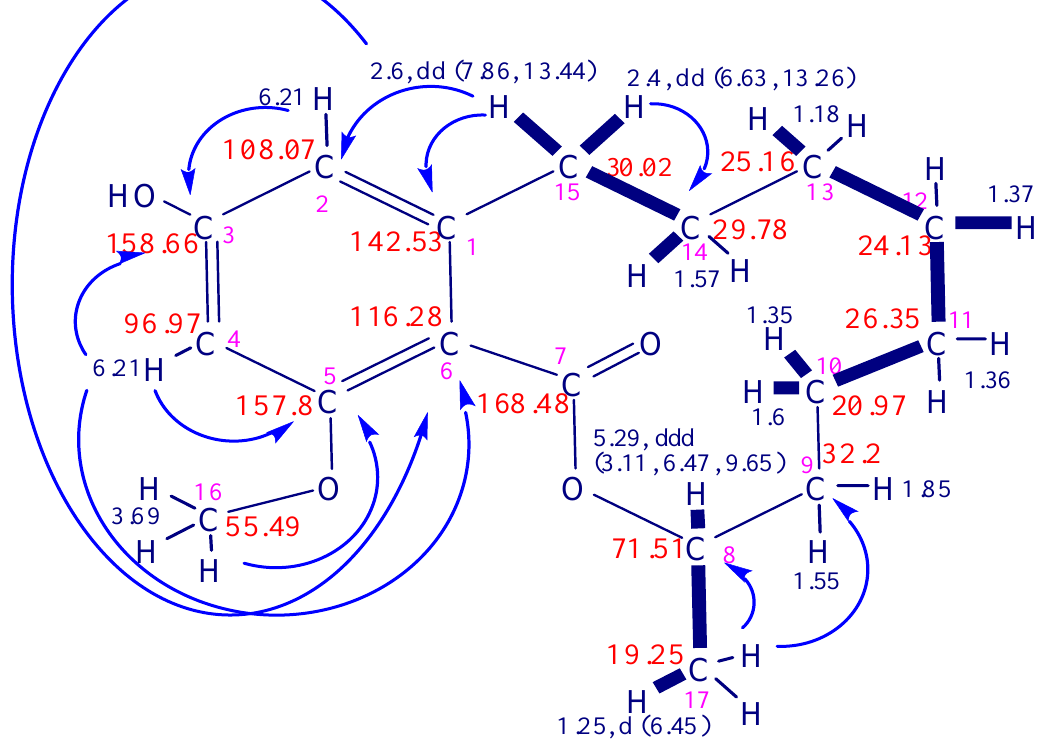
Figure 3. The structure of lasiodiplodin